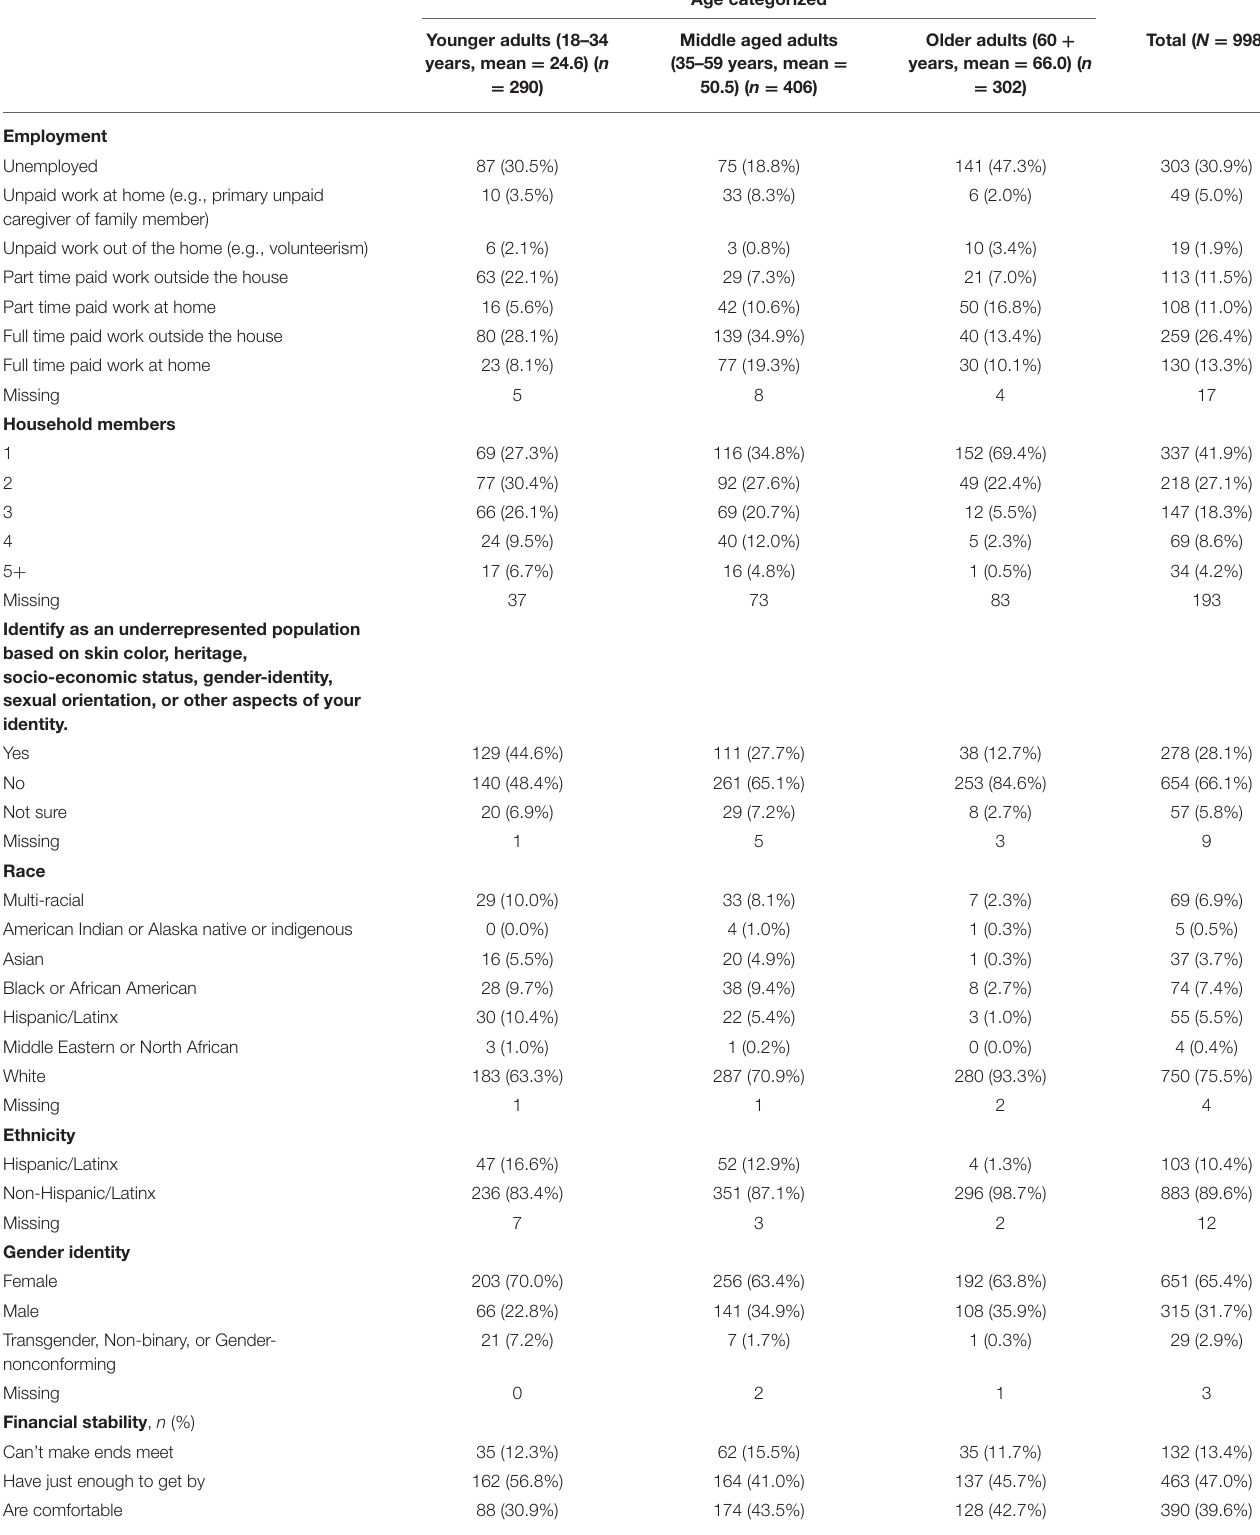
TABLE 1 | Demographics stratified by age